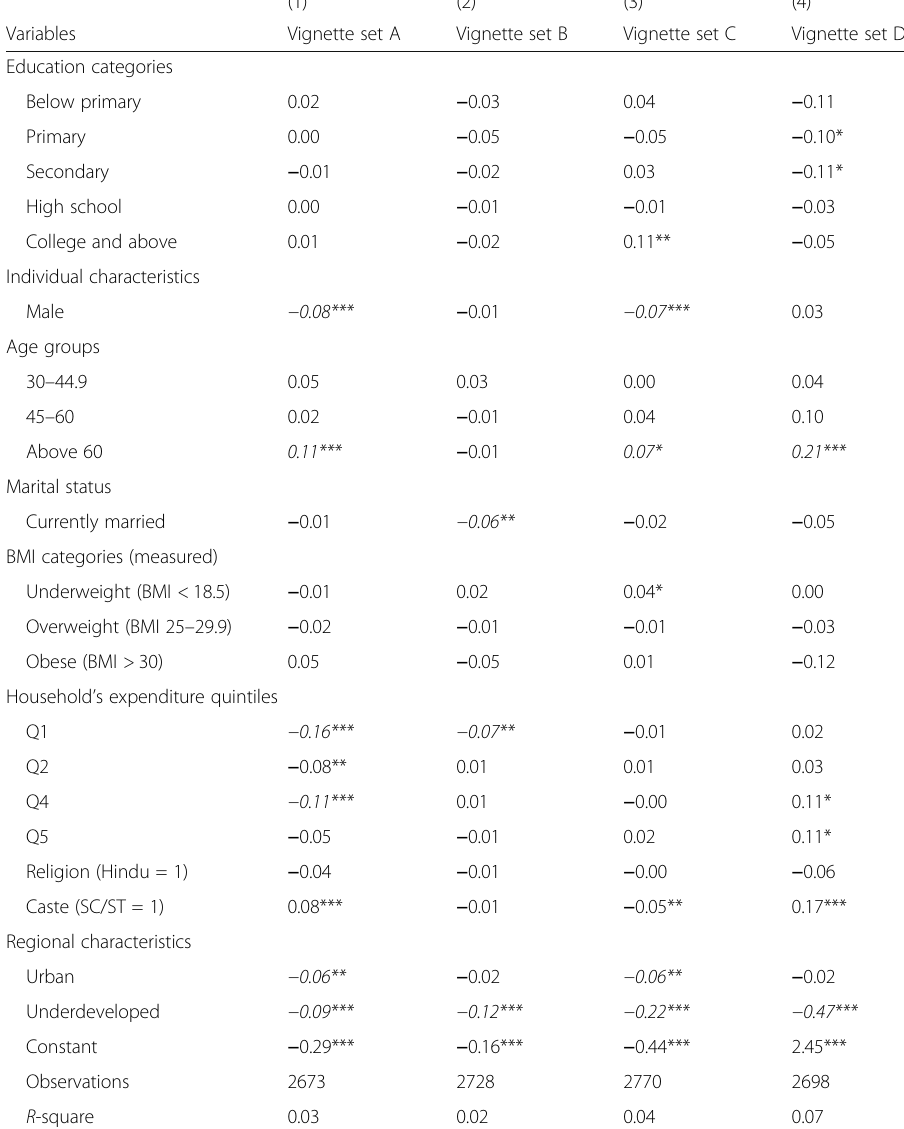
Table 11 Estimations of two-stage regressions using individual fixed